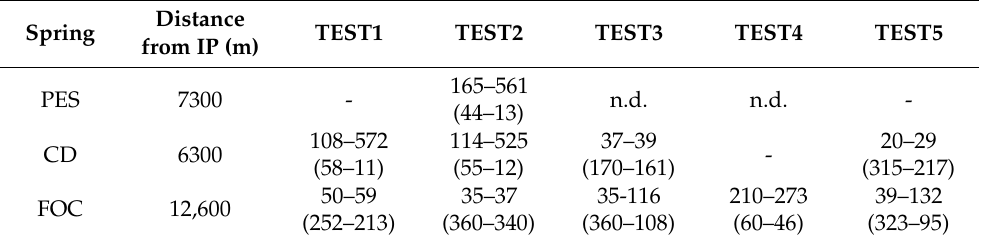
Table 4. Tracer velocity range (m / day) estimated by the free software Qtracer2 (US EPA 2002) for the five analysed tracer tests. The tracer transit time (in days), used to calculate the velocity together with the distance from the injection point (IP), is reported in